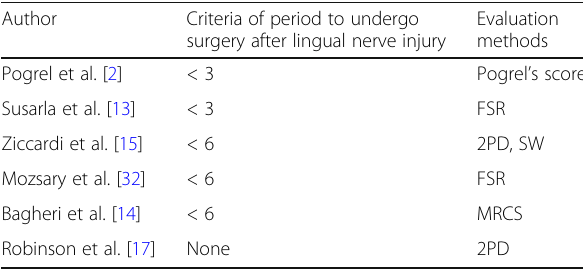
Table 5 Criteria of surgery and the evaluation methods in previous studies